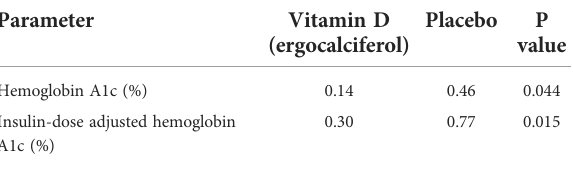
TABLE 1 Summary of the Temporal Trends in Hemoglobin A1c and the Insulin Dose Adjusted Hemoglobin A1c during the trial.